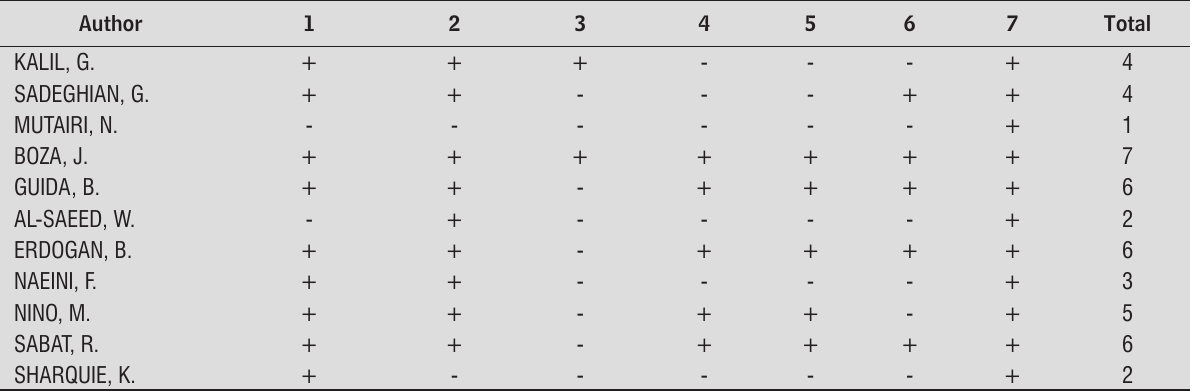
Table 1 - Methodological quality of the studies analyzed in the systematic